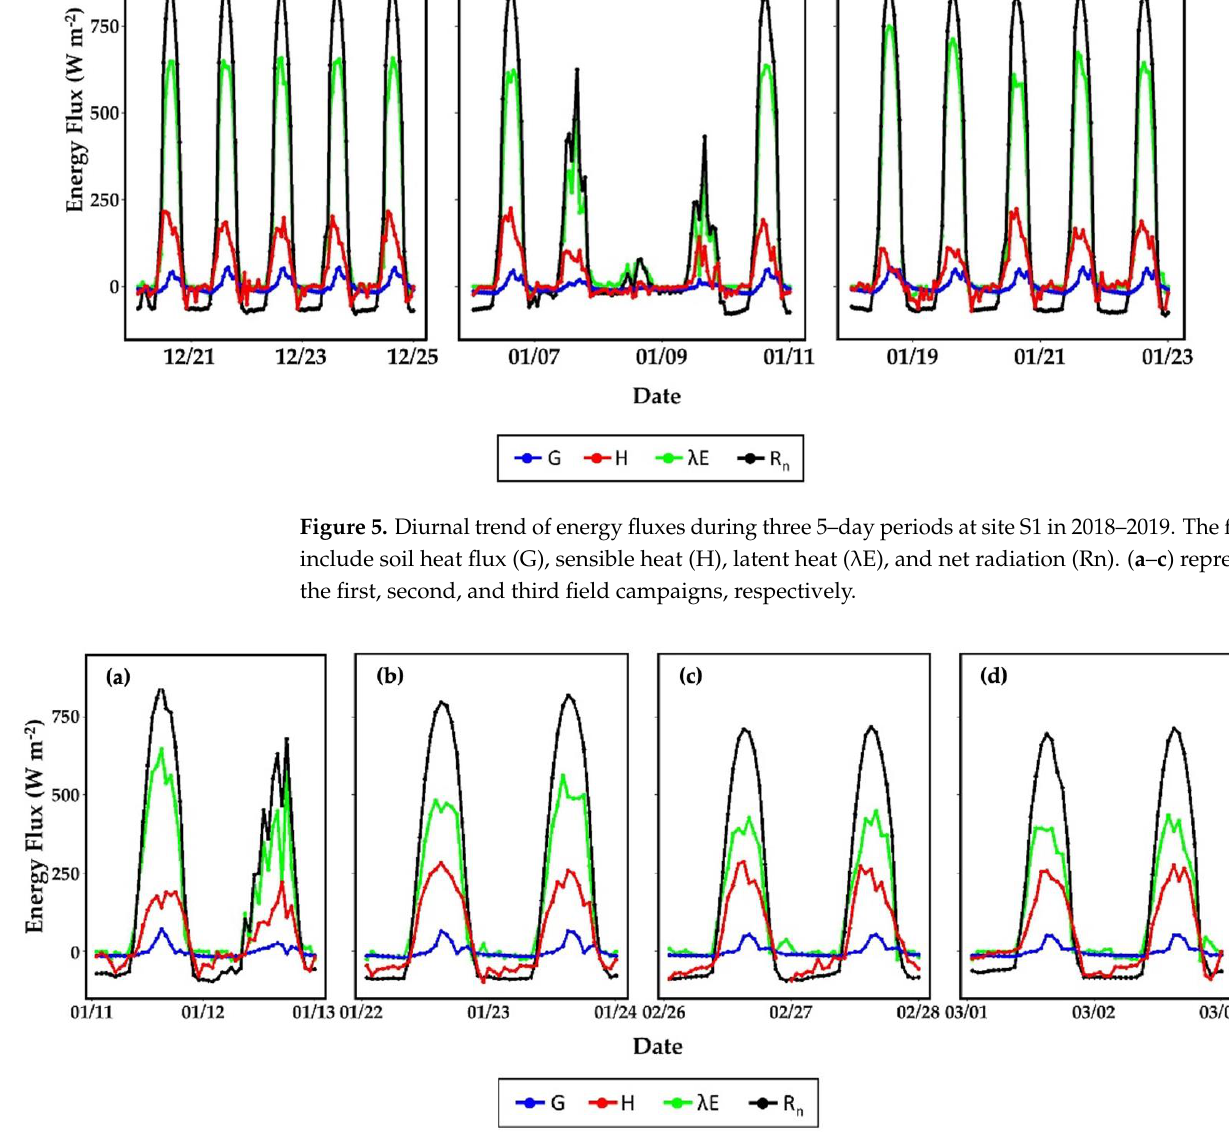
Table 2. Performance of measured and modeled ET data collected from two study sites of